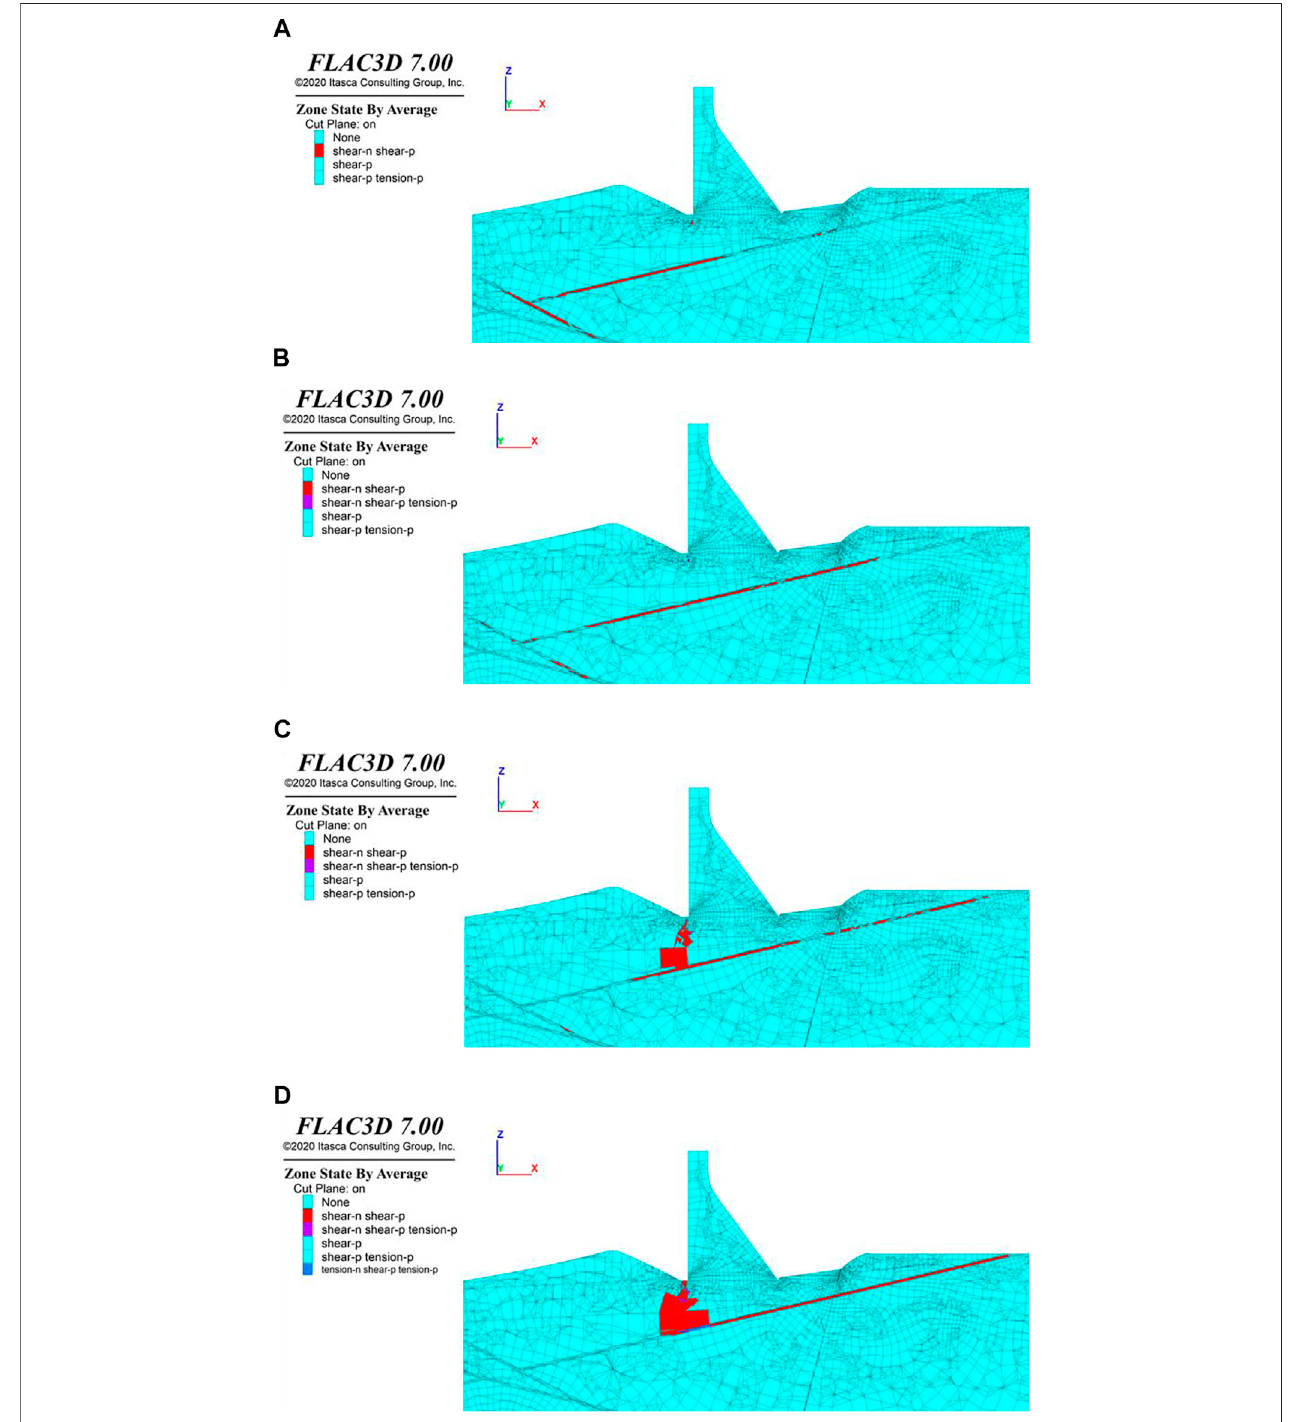
FIGURE10| Plasticzonesinthepro fi lecuttingthroughthecenterofdamsection9undertheconditionsof (A) overloadcoef fi cient2.0, (B) overloadcoef fi cient2.5, (C) overload coef fi cient 3.0, and (D) overload coef fi cient 3.2.